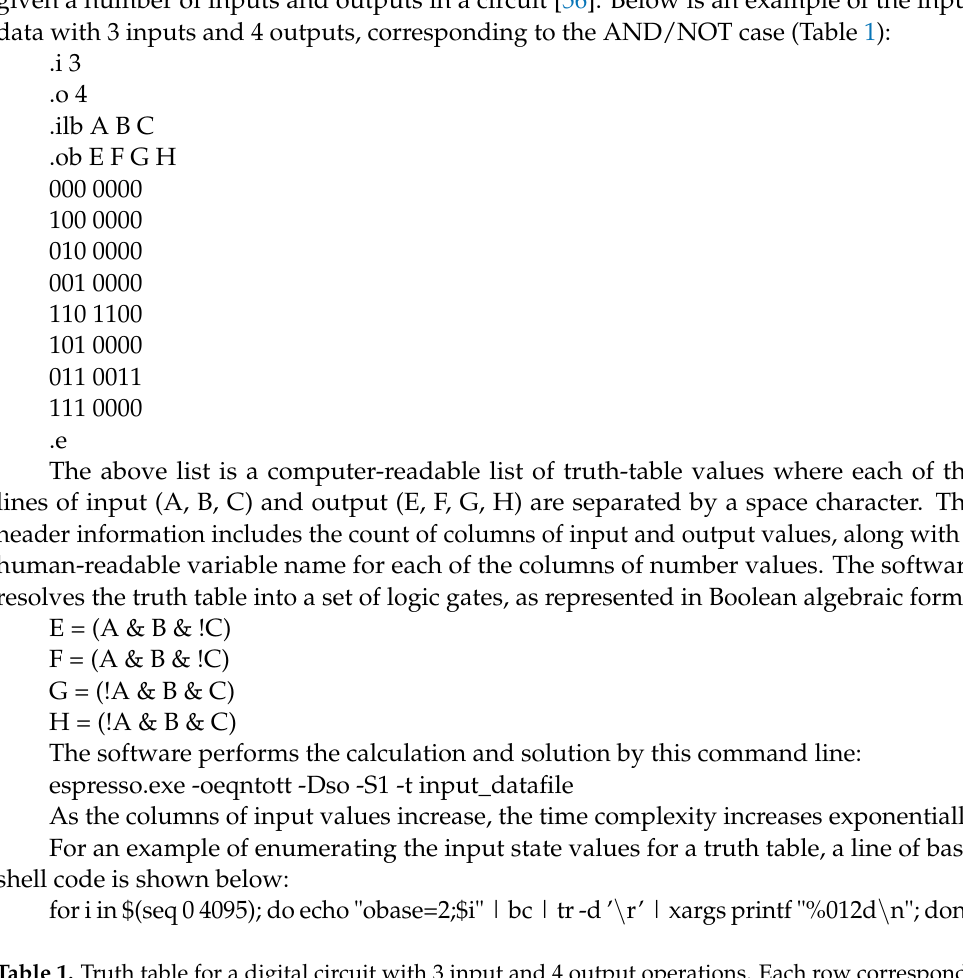
Table 1. Truth table for a digital circuit with 3 input and 4 output operations. Each row corresponds to 1 of the 8 possible input and resulting output states. The binary digit 1 is an ON state and 0 is an OFF state. An OR operation resolves to an ON state if either of two specific inputs are ON, while an AND operation resolves to an ON state where two specific inputs are ON. NOT modifies the state from ON to OFF or OFF to ON. OR/NOT AND/NOT Inputs Outputs Inputs